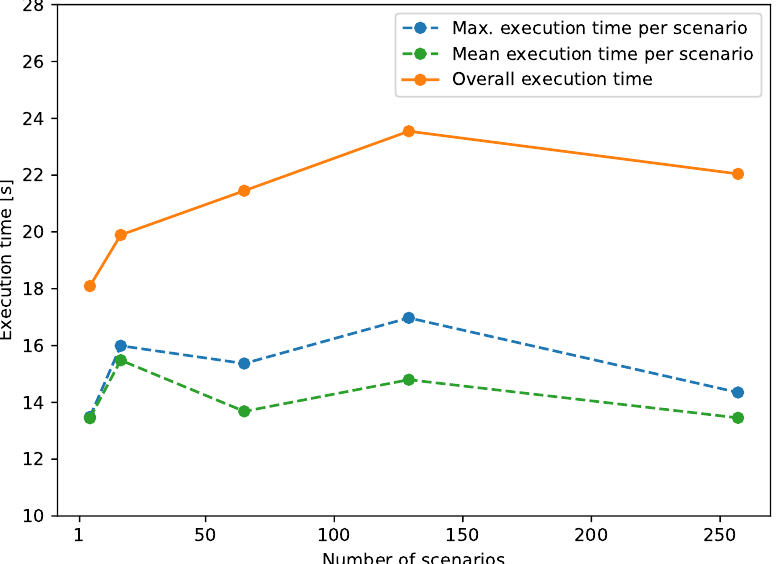
Figure 5. Test case 1 execution time of a parallel simulation with an increasing number of